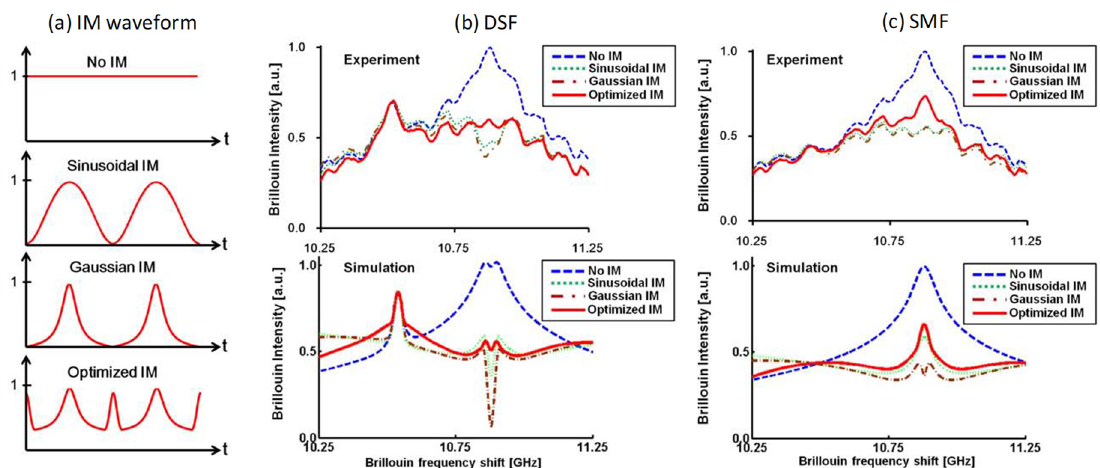
Figure 32. Experimental and simulation verification of the intensity modulation scheme in the BOCDR system [82]. ( a ) Four cases are shown: no IM, sinusoidal waveform IM, Gaussian waveform IM, and IM of Gaussian waveform and peaks to recover the power at both edges of the time-averaged LD power spectrum (optimized modulation). ( b , c ) show, respectively, the BGS measured at the DSF section and that at the SMF section.